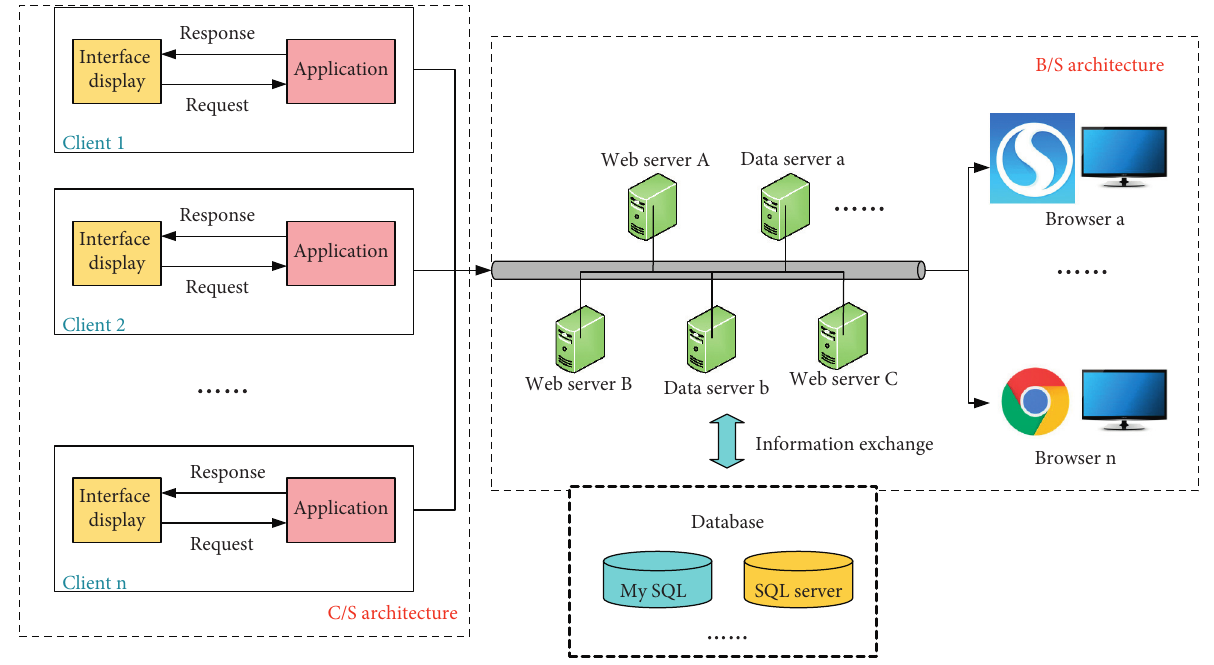
Figure 2: The overall architecture of the health information service